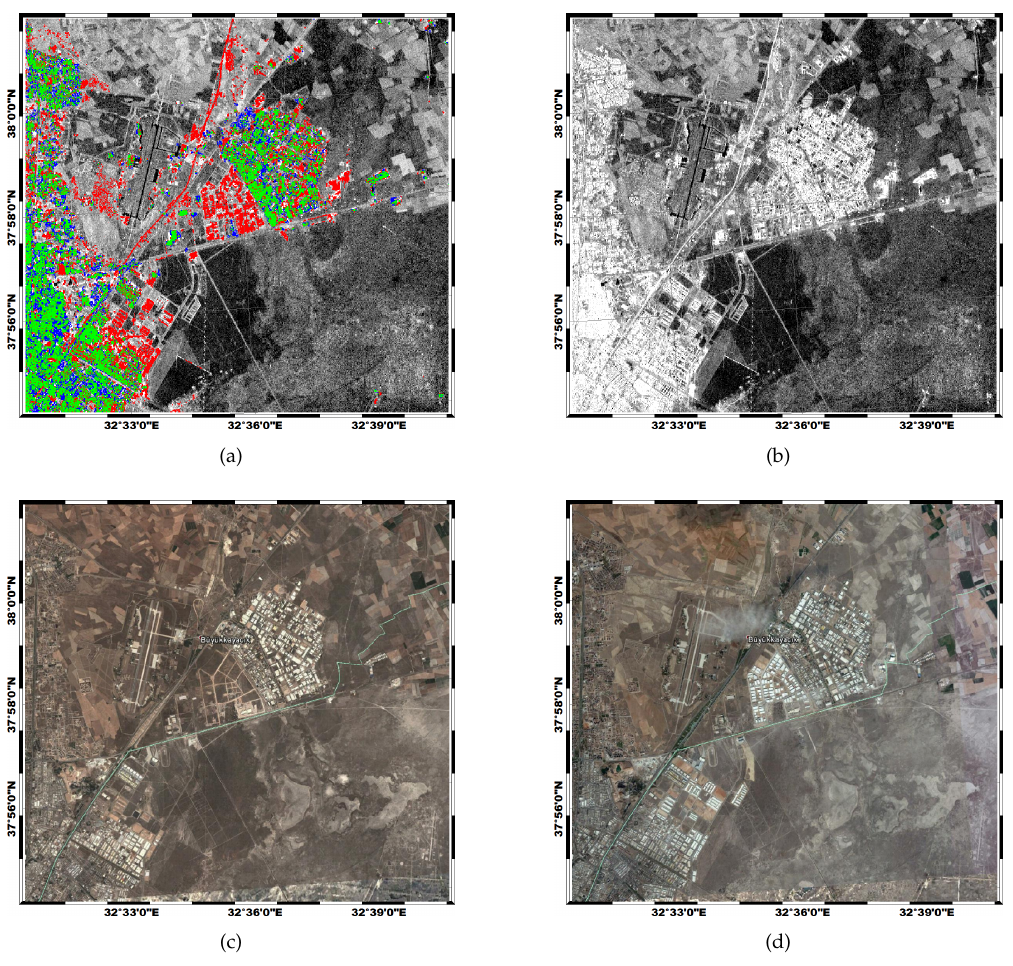
Figure 4. Illustration of new built-up areas identified in S1BM: ( a ) red—buildings detected only by S1BM; green—overlap of detected buildings by S1BM and the GUF; blue—buildings detected only by GUF. ( b ) Corresponding S1 image. Optical images from ( c ) 2013 and ( d ) 2016 (source: Google Earth).